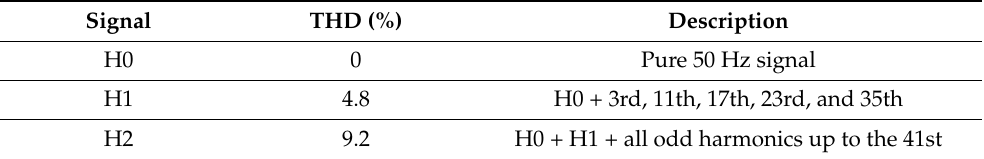
Table 1. Characteristic of the Adopted Current Signals.